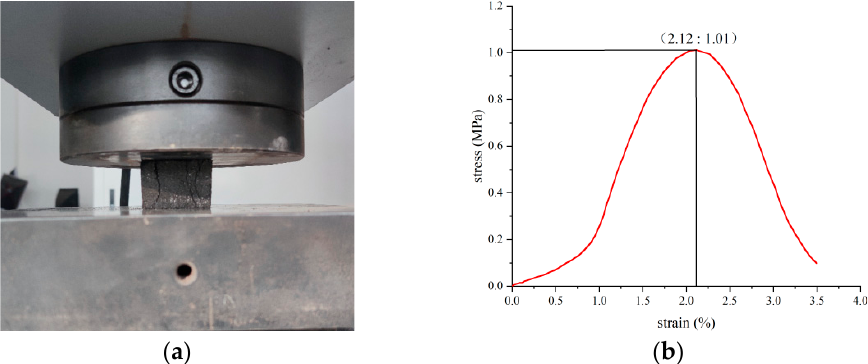
Figure 5. Uniaxial compressive strength test. ( a ) Uniaxial compression test; ( b ) typical stress–strain curve.